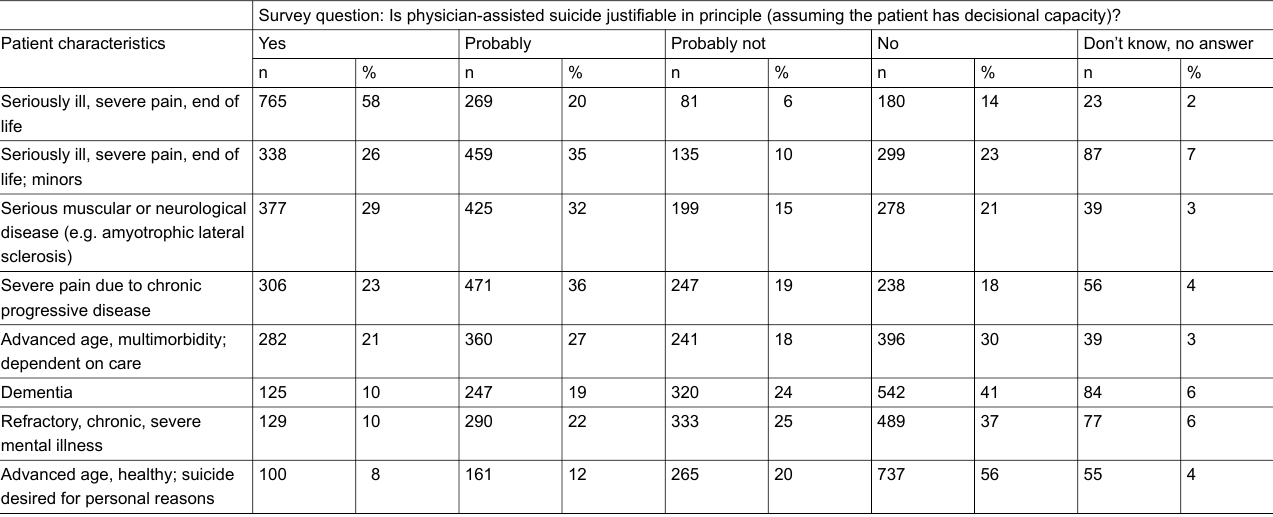
Table 3: Respondents’ assessment of whether physician-assisted suicide is justifiable in principle for various conditions. Survey question: Is physician-assisted suicide justifiable in principle (assuming the patient has decisional capacity)?